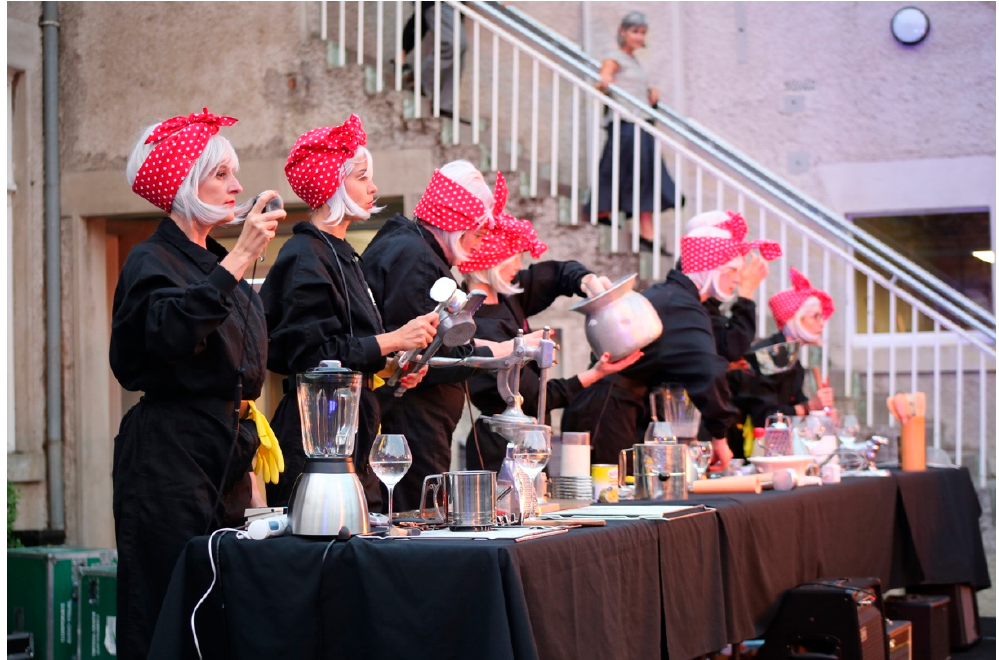
Figure 5. The local sound performance collective, Sonic Electric, performing in The Future is Female , Abbotsford Convent, Melbourne, Australia, 2018.